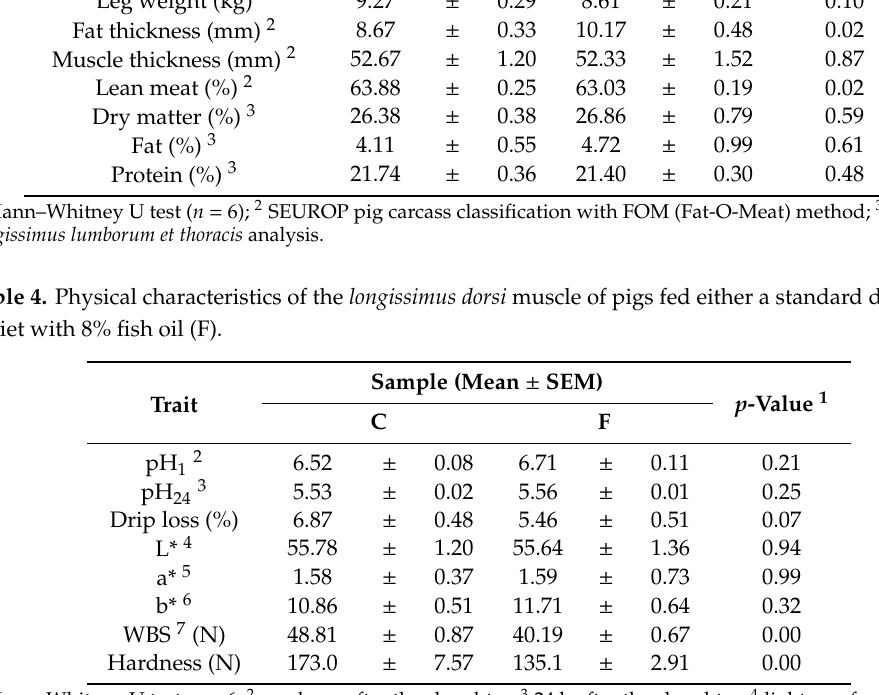
Sample (Mean ± SEM) C